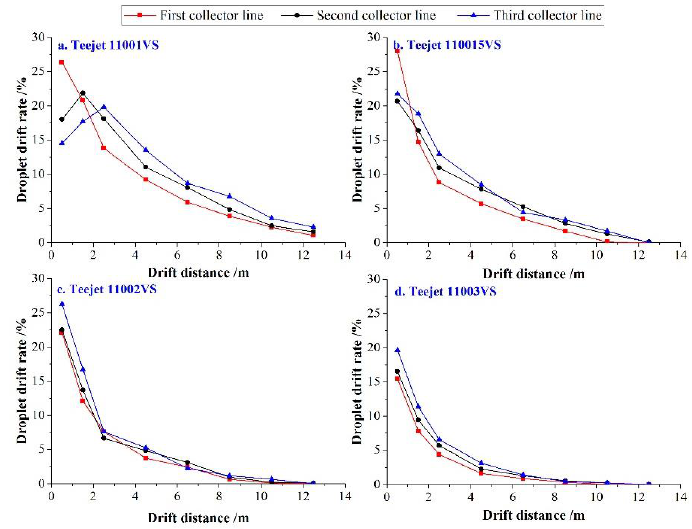
Figure 9. Droplet drift in the non-target area.